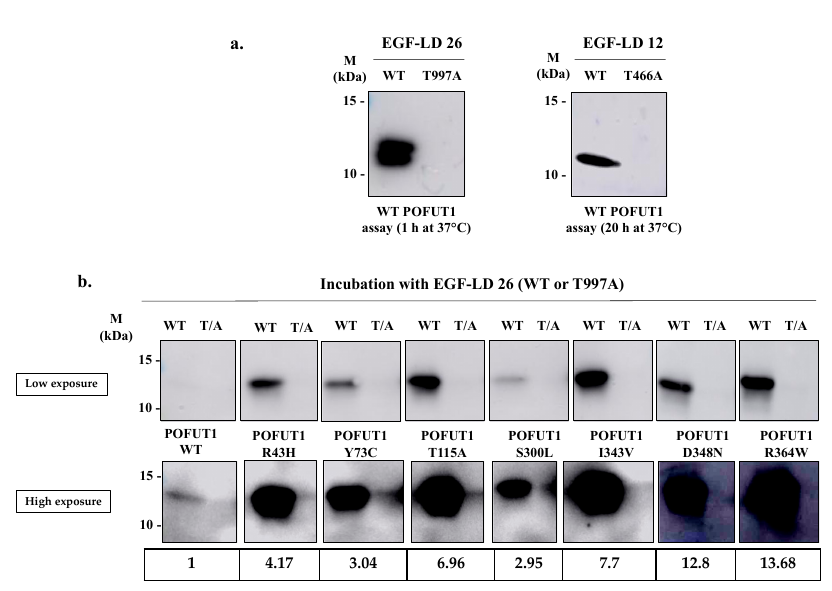
Figure 3. In vitro O -fucosyltransferase assay for activity of WT and mutated POFUT1 variants using click chemistry. ( a ) After 1 h or 20 h incubation at 37 °C of recombinant WT human POFUT1 with NOTCH1 EGF-LD 26 (WT and T997A) or EGF-LD 12 (WT and T466A) and GDP-azido-fucose, click